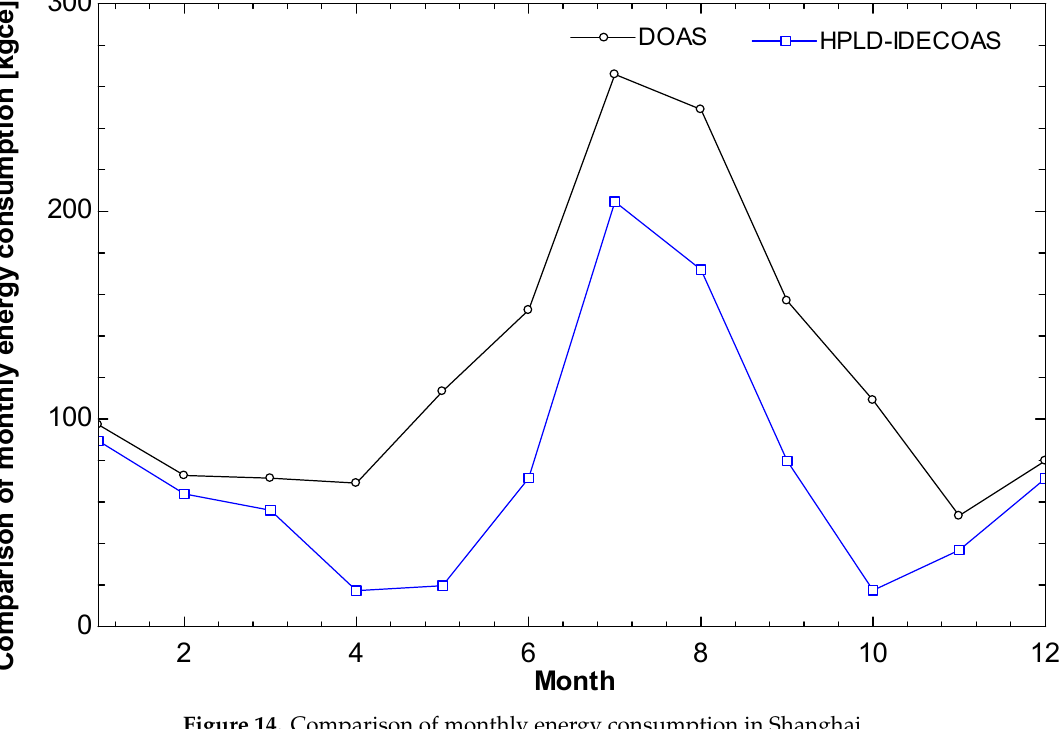
Figure 13. Comparison of monthly energy consumption in Guangzhou.